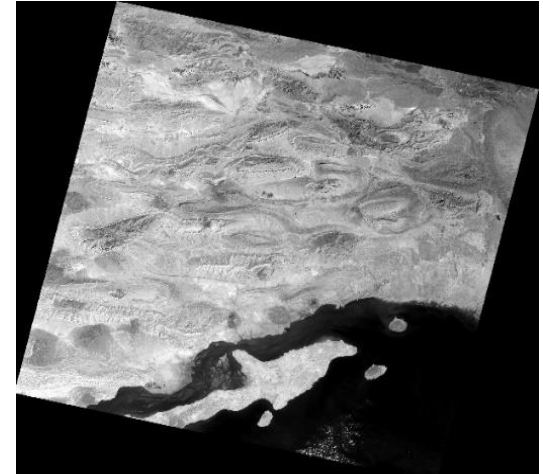
Figure 1. Landsat-8 image of Khamir habitat